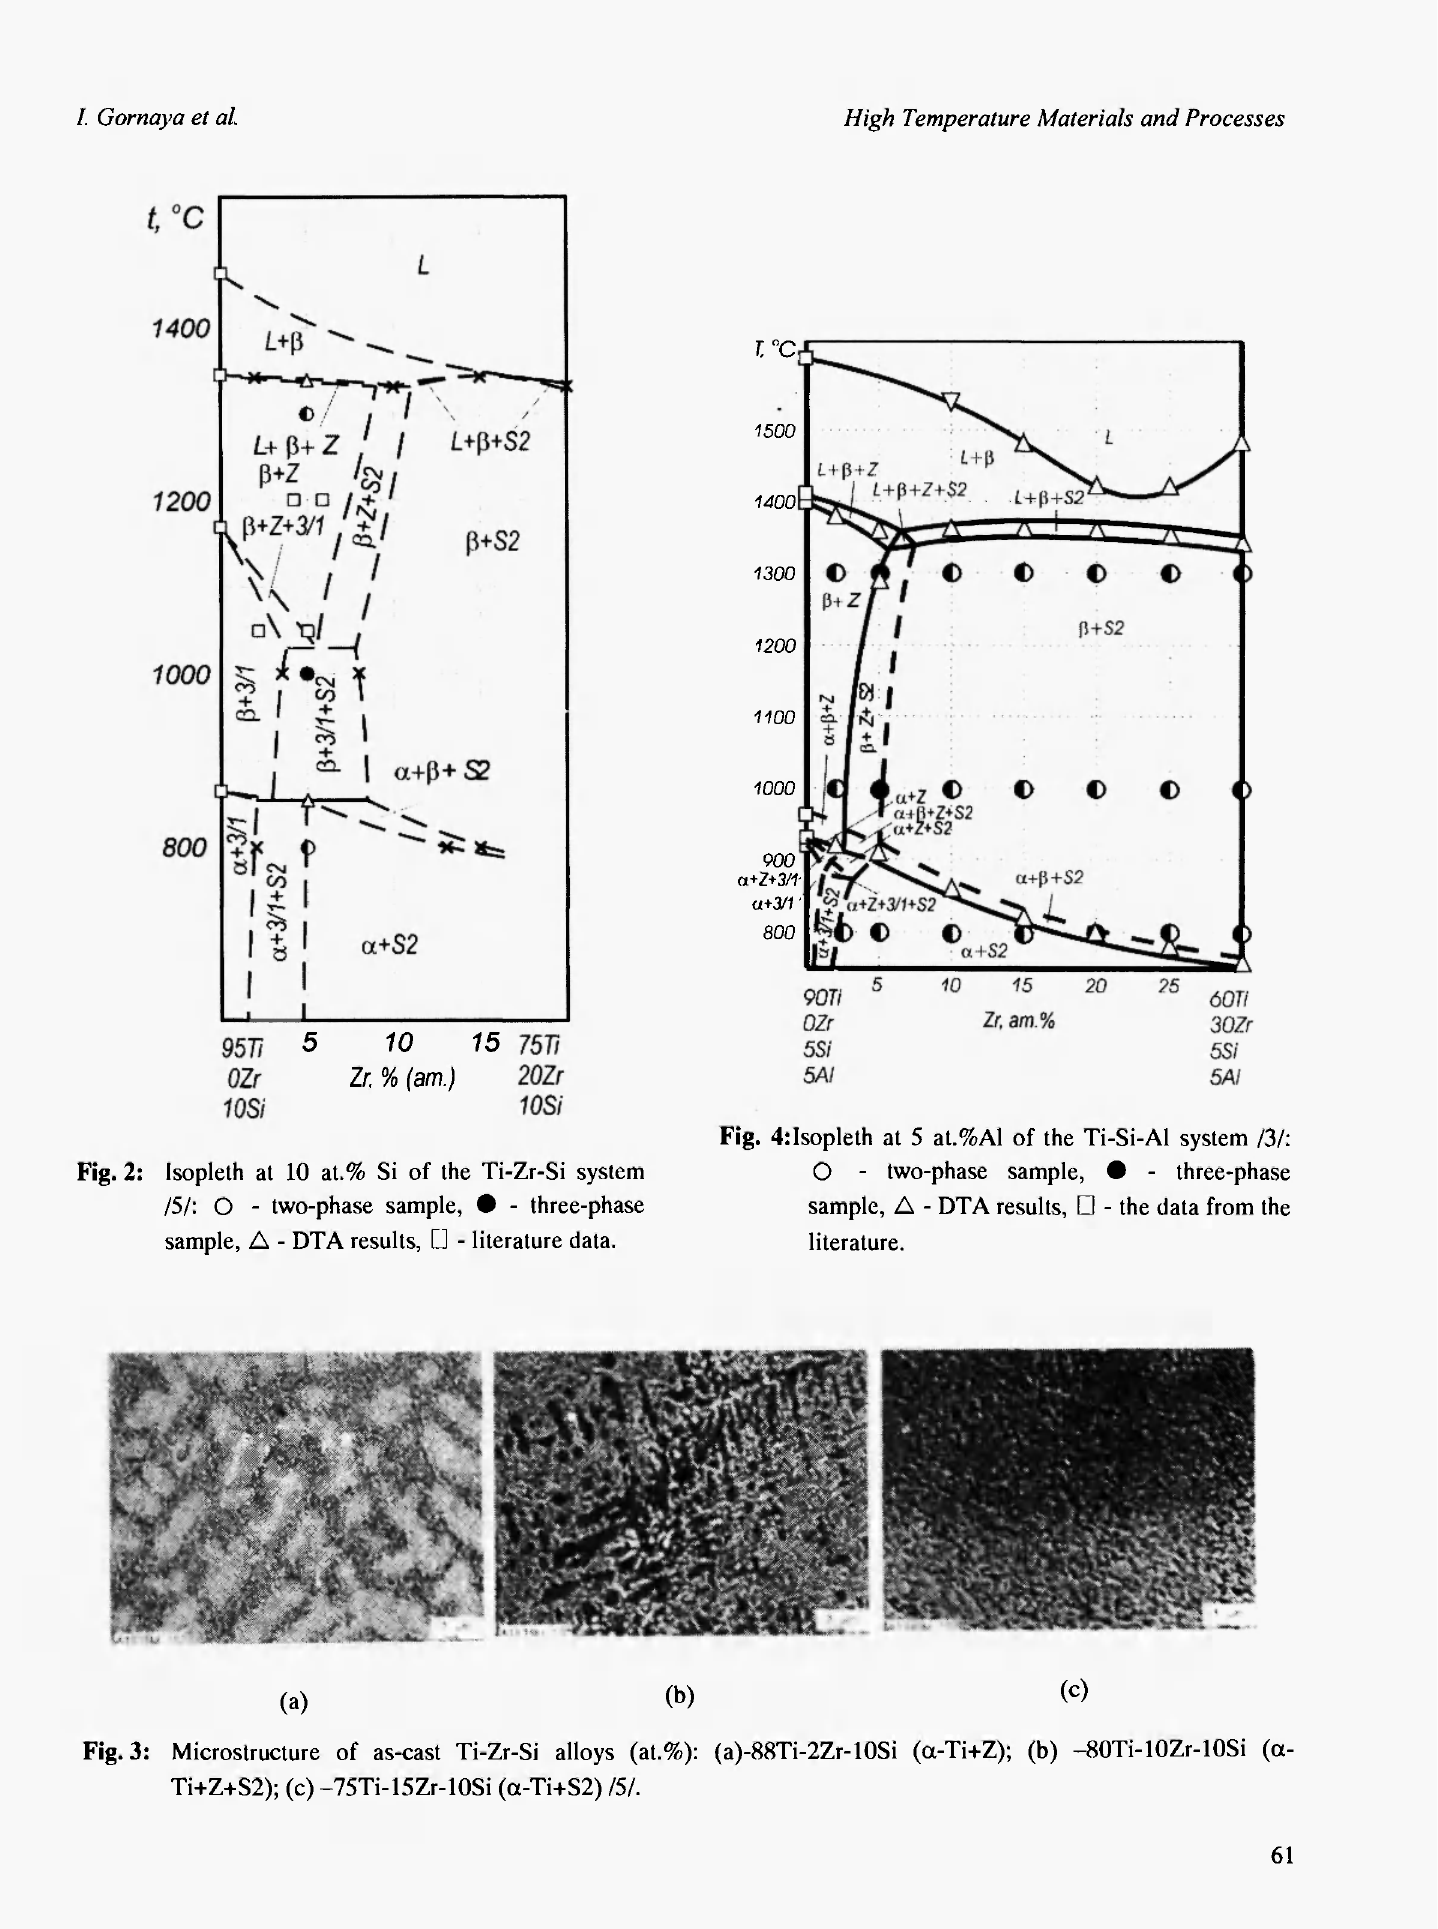
Fig. 4: Isopleth at 5 at.%Al of the Ti-Si-Al system /3/: Ο - two-phase sample, · - three-phase sample, Δ - DTA results, • - the data from the literature.